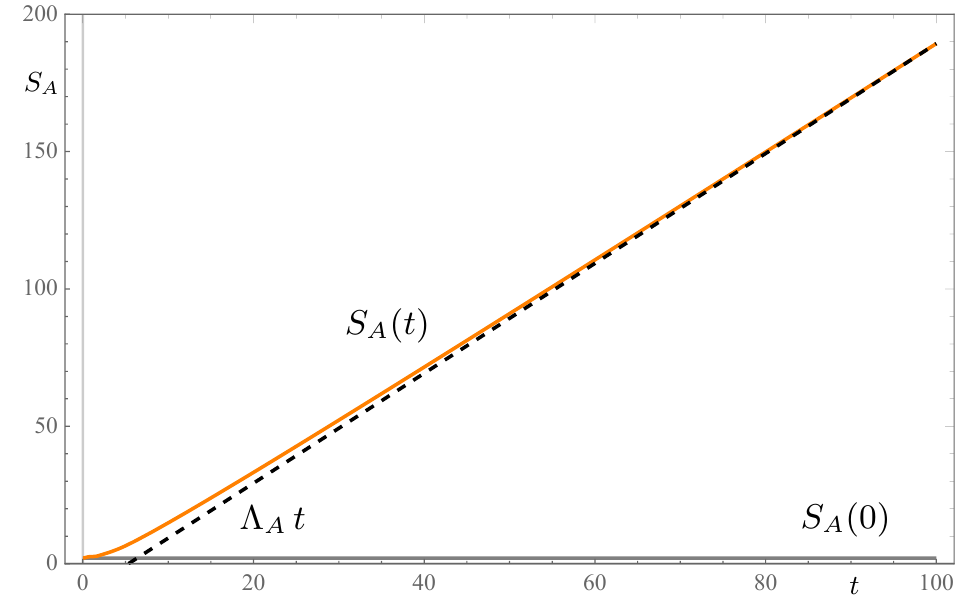
Figure 6 . Symmetry breaking and the inverted quadratic potential . We compute the entanglement entropy S A ( t ) numerically for the time evolution with the unstable Hamiltonian (4.13). We set (cid:22) = 1. The subsystem A is de(cid:12)ned in (4.17) with R =